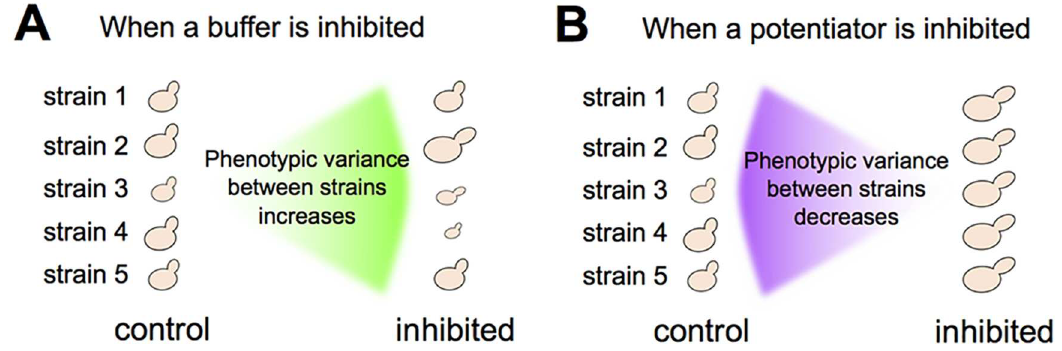
Fig 1. Responses of genetically diverse populations to inhibition of a buffer or potentiator. (A) Inhibitinga protein that buffers the phenotypiceffects of genetic variation will reveal those effects, which increasesthe phenotypicdiversity between genetically distinct individuals. (B) Inhibitinga protein that potentiates the phenotypiceffects of genetic variation will diminish those effects, which decreasesthe phenotypicdiversity between geneticallydistinct